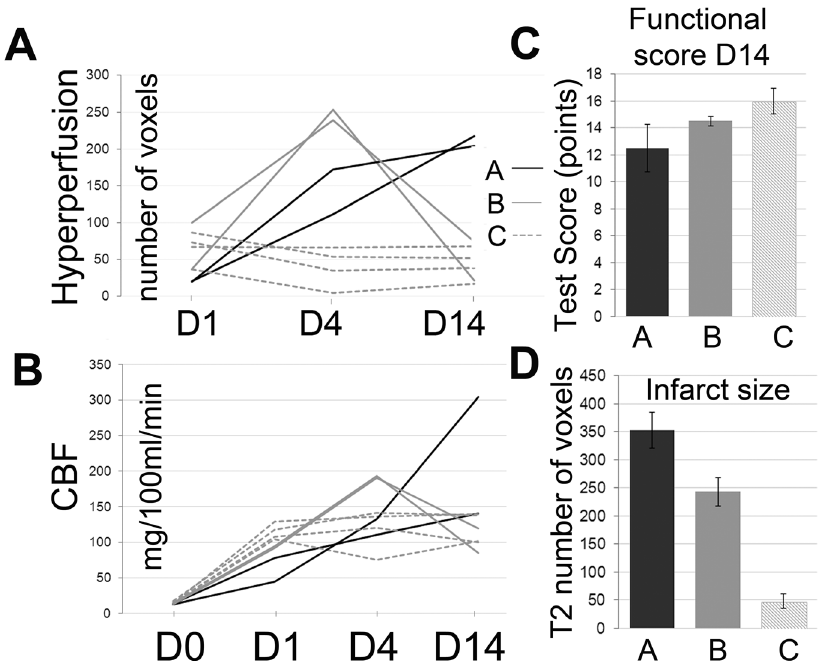
Figure 4. Hyperperfusion and CBF in individual animals. 4A: number of hyperperfused voxels on days 1, 4 and 14 (D1, D4, D14). The three infarct types (A, B, C) show differences in the number of hyperperfused voxels over time. 4B: absolute CBF values (given in mg/100 ml/min) within ischemic voxels ( , 30 mg/100 ml/min on d0) over time (D0, D1, D4, D14). 4C: Mean functional test scores on D 14 (higher scores indicate less functional impairment) show a gradual increase between infarct types (A, B, C); 4D: Infarct size determined from D14 T2-maps in the three different infarct types.